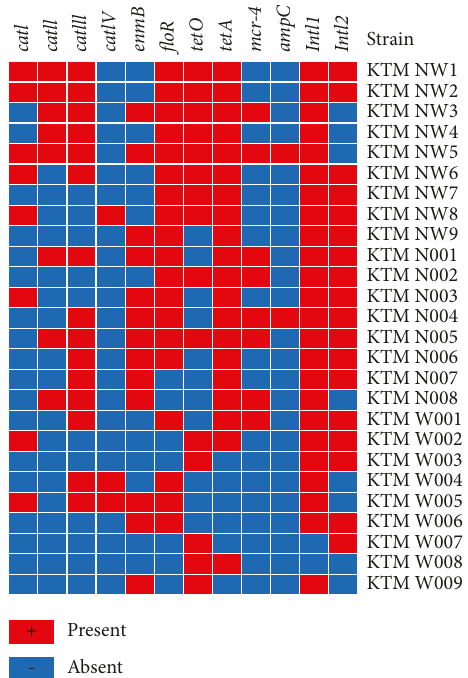
Figure 3: Antibiotic resistance profile of the C. jejuni strains using the 12 amplified antibiotic resistance genes in this study. The red colour represents the presence of antibiotic resistance genes, and blue represents the absence of antibiotic resistance